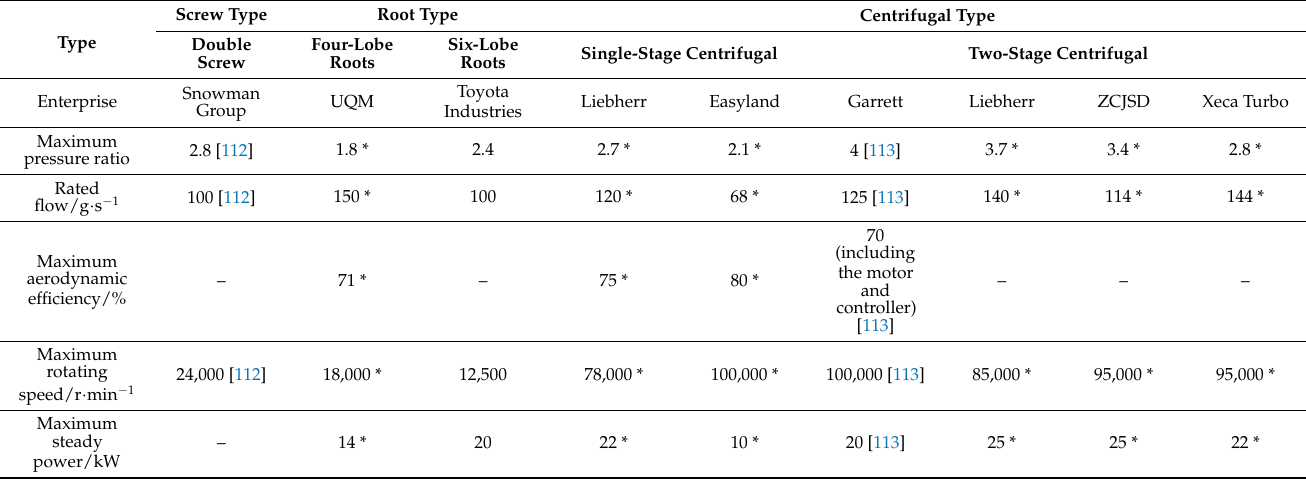
Table 6. Performance comparison of products manufactured by major compressor enterprises.